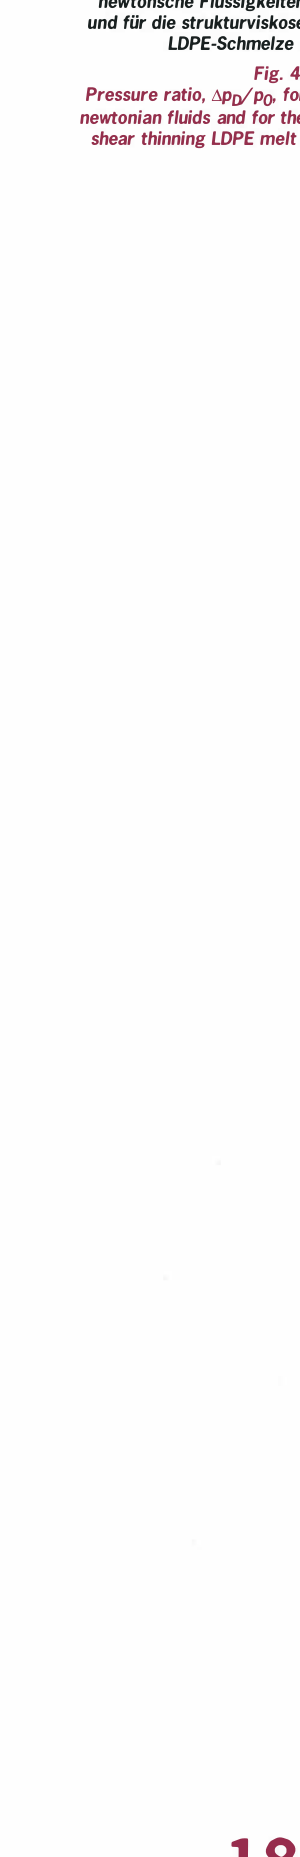
Fig. 4: Pressure ratio, "'-Po/Po. for newtonian fluids and for the shear thinning LOPE melt